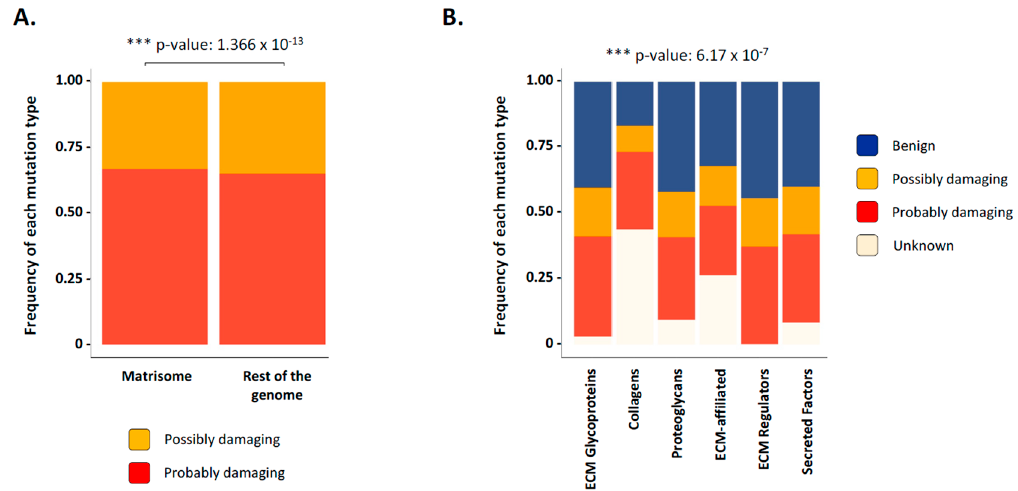
Figure 5. Prediction of mutational effects of matrisome genes on function. ( A ) Bar chart presents the frequency of possibly damaging (yellow) or probably damaging (red) mutations in matrisome genes and non-matrisome genes across all cancer types studied. ( B ) Bar chart presents the frequency of the predicted mutational effect of matrisome genes on function: benign (blue), possible damaging (yellow), probably damaging (red), and unknown (light pink) across all cancer types studied. See also Figure S7.